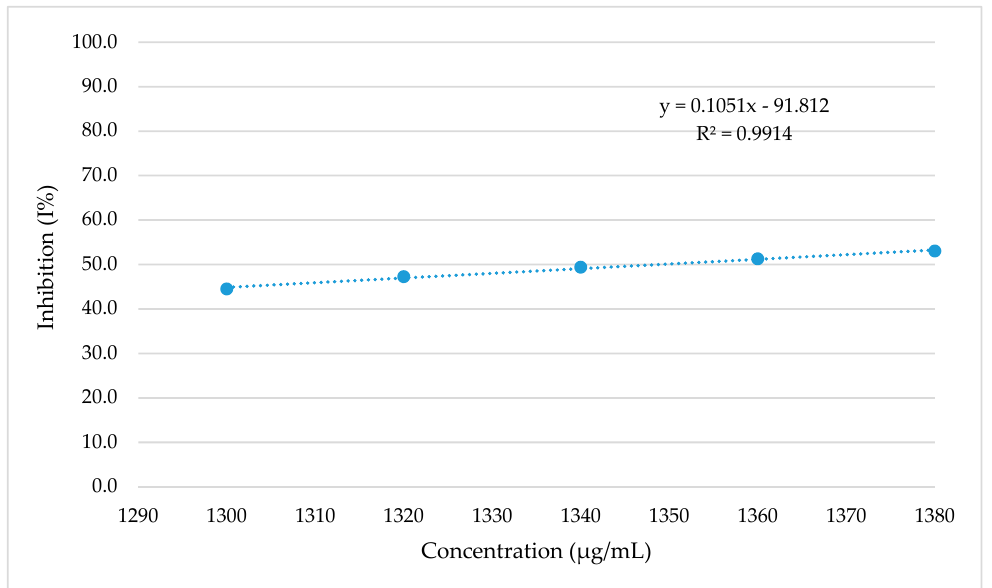
Table 5. The result of optimum point experiment.